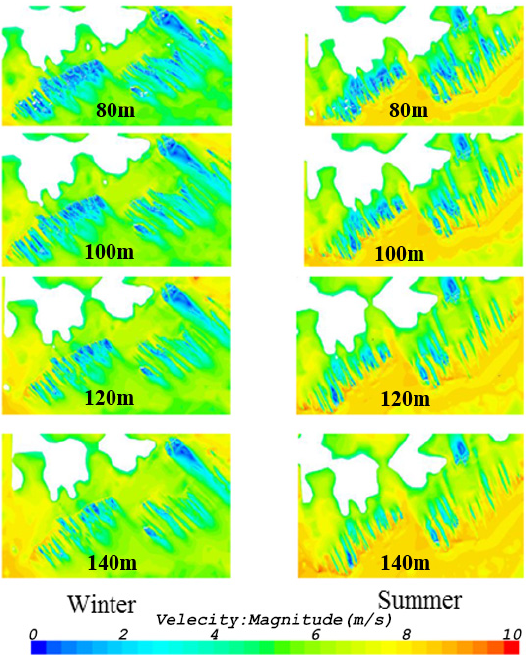
Figure 6. Wind speed chart at different heights.